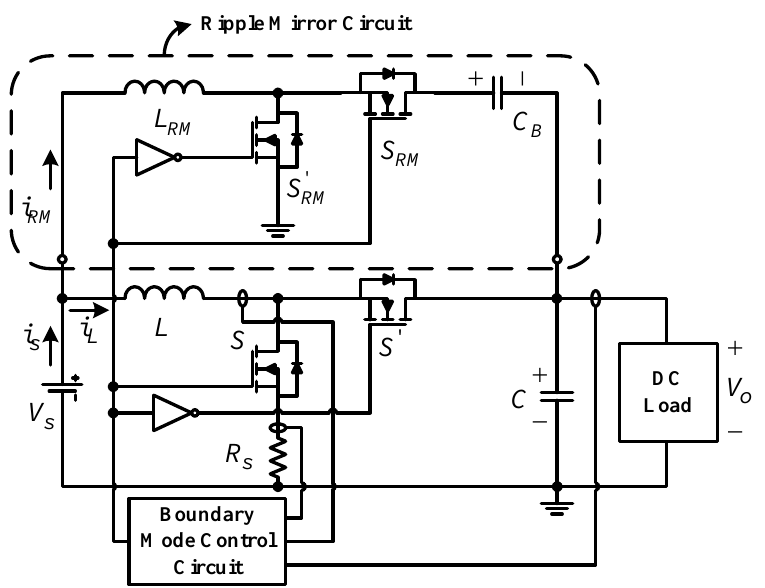
Figure 1. Configuration of the zero input current ripple ZVS/ZCS boost converter.